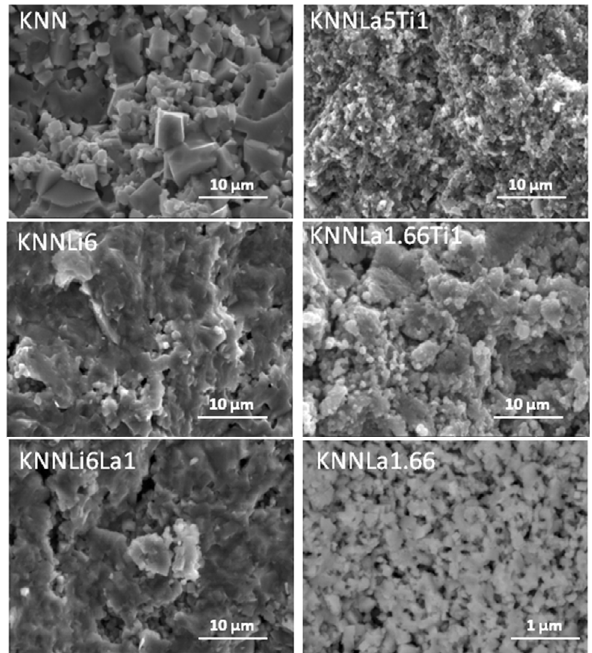
Fig. 5 SEM images of pure and doped KNN sintered at different